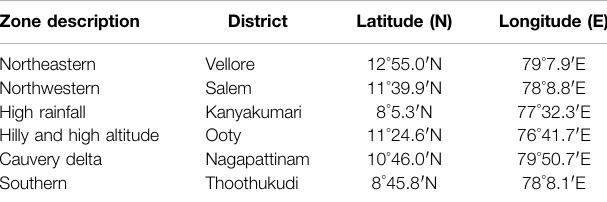
TABLE 2 | Geographic coordinates of various zones in Tamil